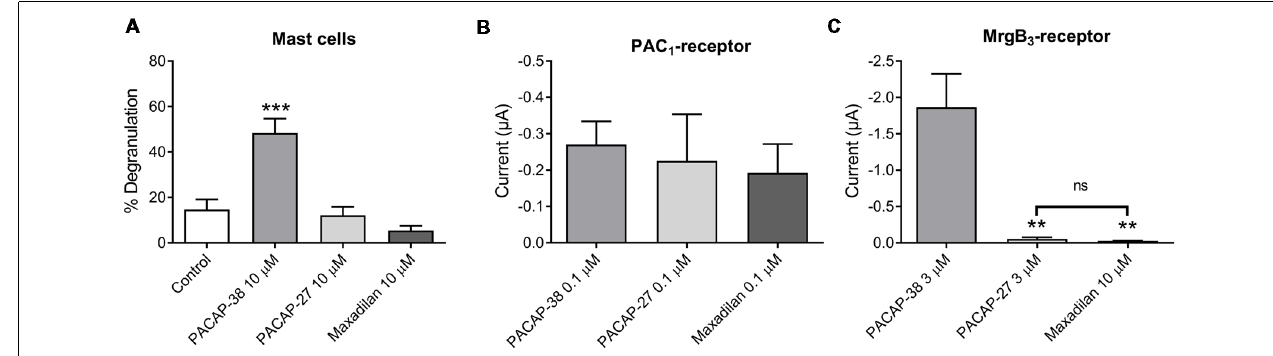
FIGURE 4 | Effect of PACAP-38, PACAP-27 and maxadilan (PAC 1 -receptor agonist) on (A) rat meningeal mast cell degranulation following 30 s of 10 µ M ligand stimulation. PACAP-38-induced a strong degranulation of meningeal mast cells. The mast cells were unresponsive to PACAP-27 and maxadilan. Values are given as percentage of degranulated mast cells from the total number of counted mast cells, n = 5–11. (B) Measurements on PAC 1 -receptor-expressing Xenopus laevis oocytes using two-electrode voltage clamp showed similar changes in current during 60 s perfusion of PACAP-38, PACAP-27 or maxadilan (all ligands 0.1 µ M, n = 14–21). (C) In MrgB 3 -receptor-expressing oocytes PACAP-38 and PACAP-27 were perfused in a concentration of 3 µ M and maxadilan at 10 µ M ( n = 8–12). Only PACAP-38 caused a change in current. All measurements were done at a holding potential of − 70 mV. In (A) . ∗∗∗ represent p < 0.001 as compared to control